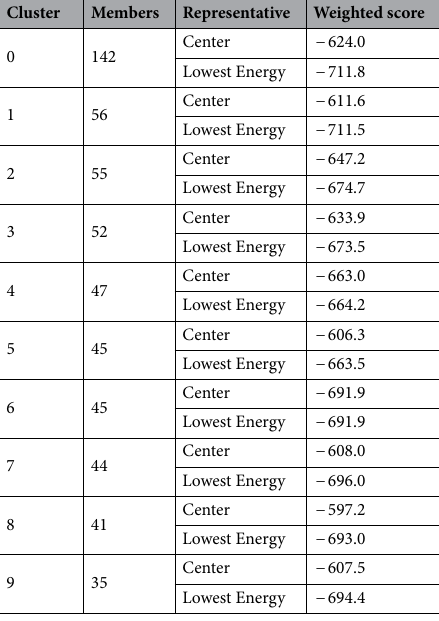
Table 3. Docking energy values generated by ClusPro server.